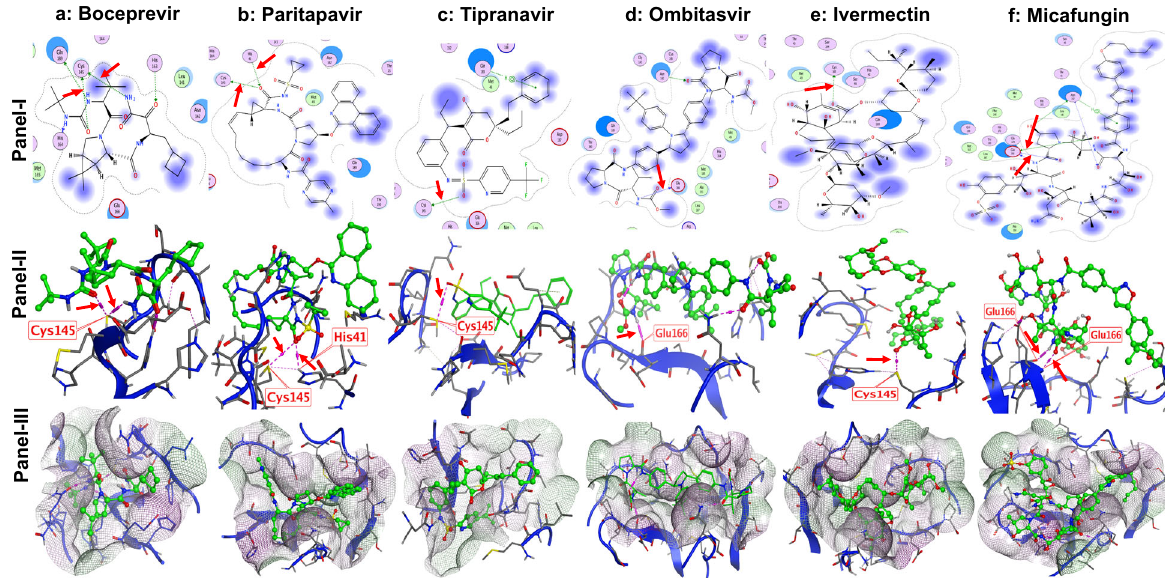
Fig. 6 Structural analysis and interaction of the potential inhibitors with SARS-CoV-2 3CLpro enzyme. Inhibitors were docked with active site of 3CLpro protein. Panel-I: ligand interaction map. Panel-II: interaction of inhibitors speci fi c amino acids of 3CLpro at active site. Panel-III: lipophilic cavity of active site with drugs interacting with speci fi c amino acids. Boceprevir ( a ), partapravir ( b ), tipranavir ( c ), ombitasvir ( d ), ivermectin ( e ), and micafungin ( f ) are arranged in columns for comparison. Drugs are represented in green color with ball and stick model. Arrows indicate the C – H, N – H, and C – O bonds between drugs and with Cys 145 , His 41 , and Glu 166 residues since they are essential for the enzymatic activity of 3CLpro enzyme. However, we also observed the drugs interacting with neighboring amino acid residues.